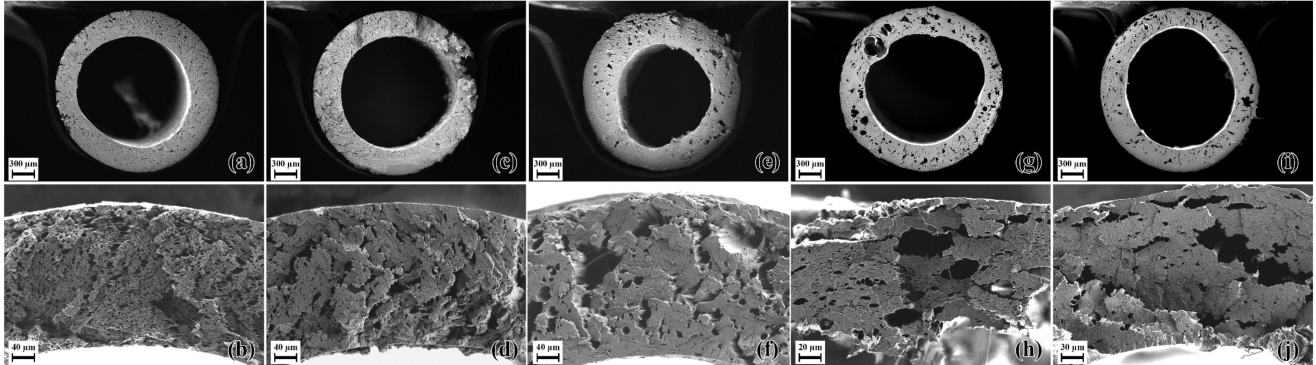
Figure 13. E3_PEG200_20 foams at various nozzle temperatures (T N ): ( a , b ) T N = 145 ◦ C; ( c , d ) T N = 150 ◦ C; ( e , f ) T N = 155 ◦ C; ( g , h ) T N = 160 ◦ C; ( i , j ) T N = 165 ◦ C. The images of the en- tire cross-sections of the extrudates are given, along with close-up views of the cross-sections of the